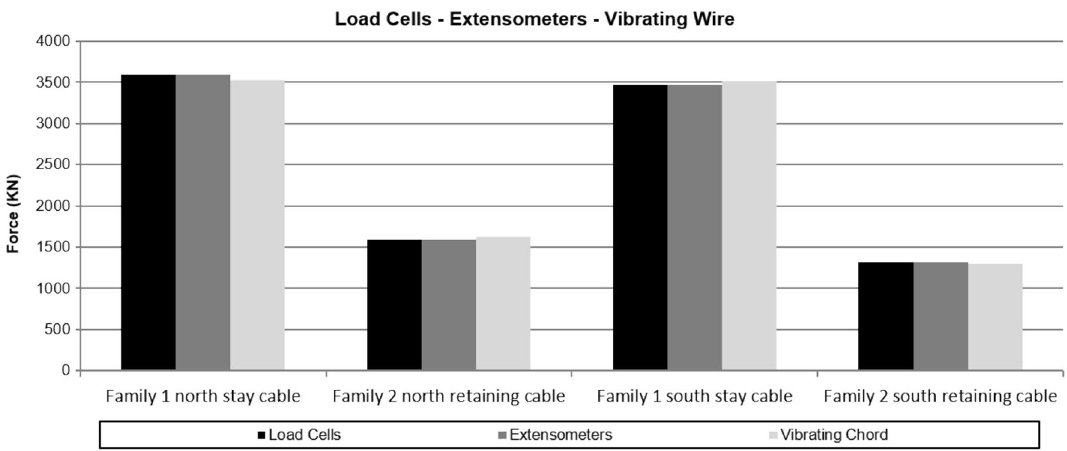
Figure 14. Effort facilitated by each of the structural monitoring techniques used.